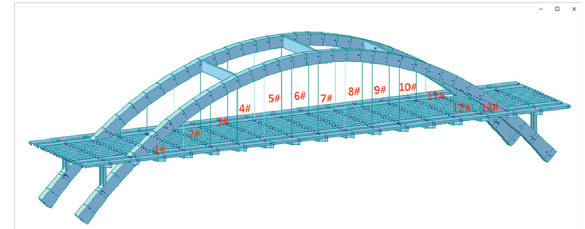
Figure 3: A bridge in Southwest